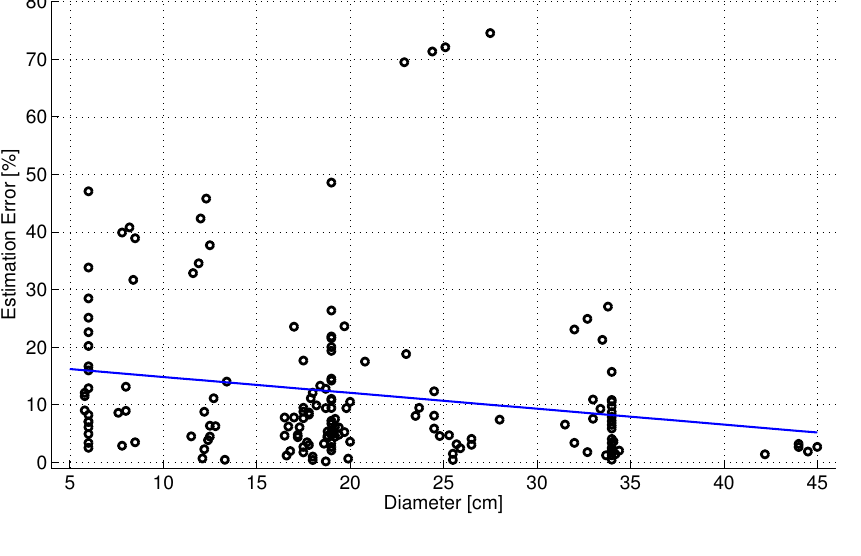
Figure 8. The estimation error increases with increasing distance. The size of the circles corresponds to the actual diameter of the trees (n =